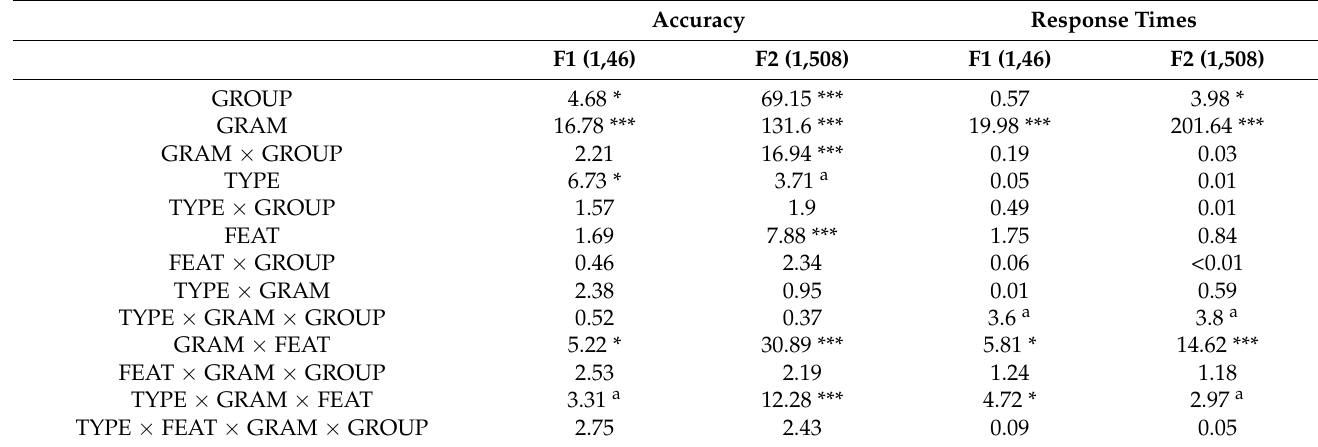
Table 4. Statistical results (accuracy and response times). Notes: GROUP: type of participants (natives, non-natives); GRAM: grammaticality (grammatical, ungrammatical); TYPE: predicate type (agent subject verbs, patient subject verbs); FEAT: feature type (person, number); F1: analysis by subject;